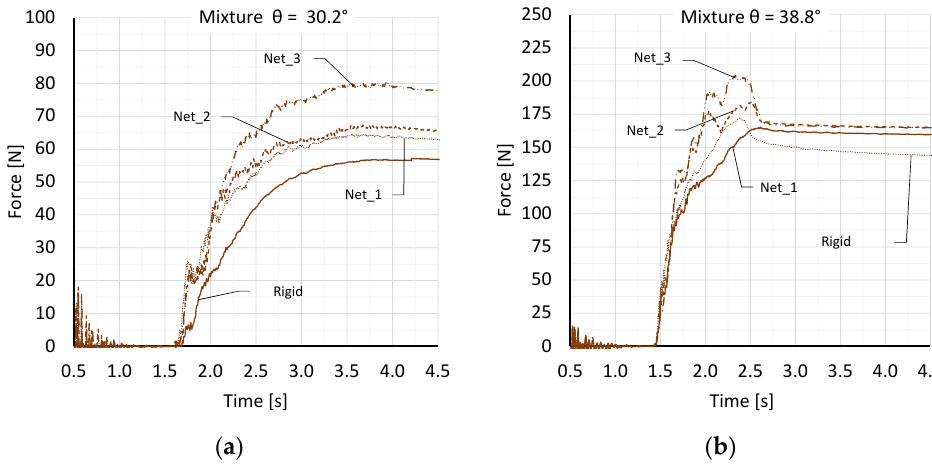
Figure 11. Force–time history for flexible barriers, mixture and inclinations of the flume base ( θ ) of ( a ) 30.2° and ( b ) 38.8°.